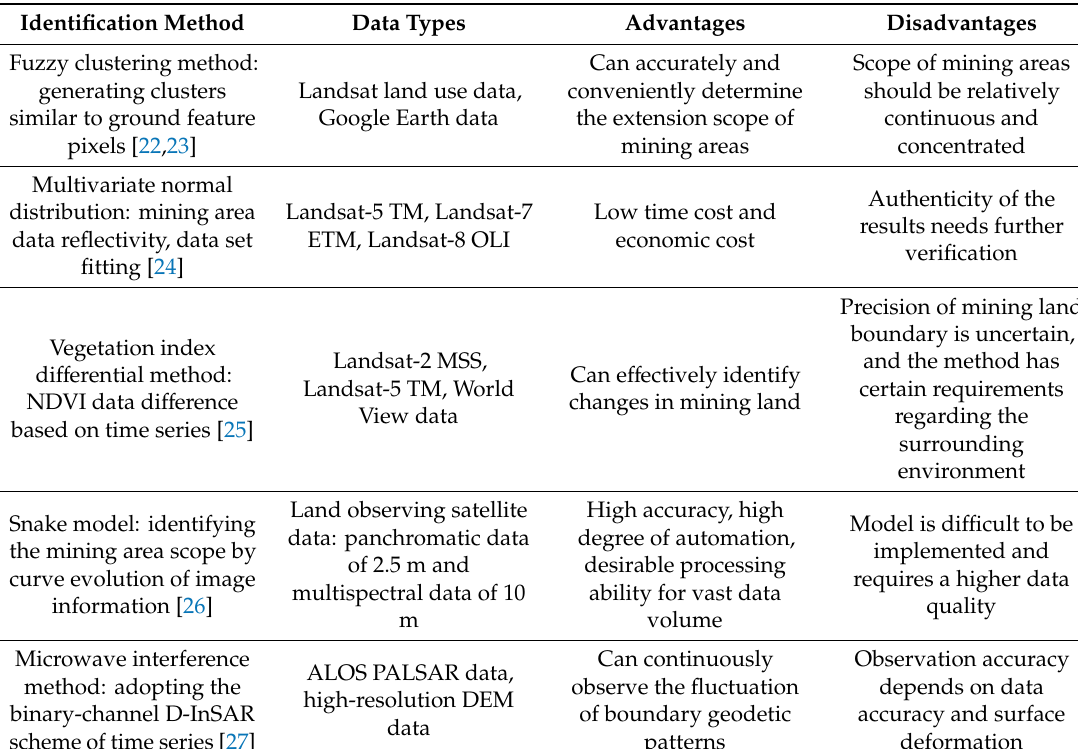
Table 1. Remote sensing identification of mining area